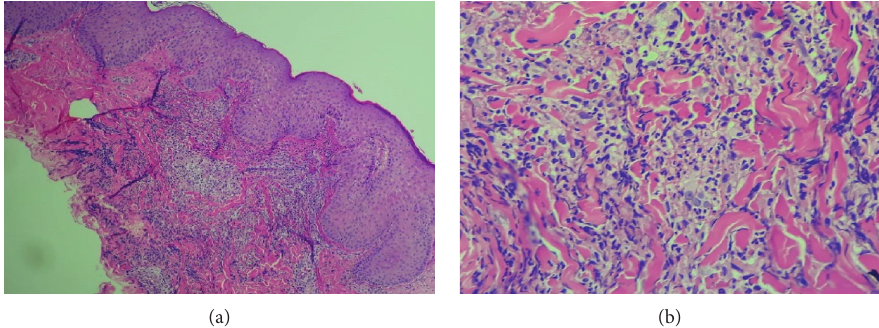
Figure 2: Dermal pathology showing lymphohistiocytic infiltrate and neutrophil granulocytes, consistent with bowel-associated der- matosis-arthritis syndrome (BADAS). Power magnification 40x (a) and 200x (b) of skin slides (hematoxylin-eosin